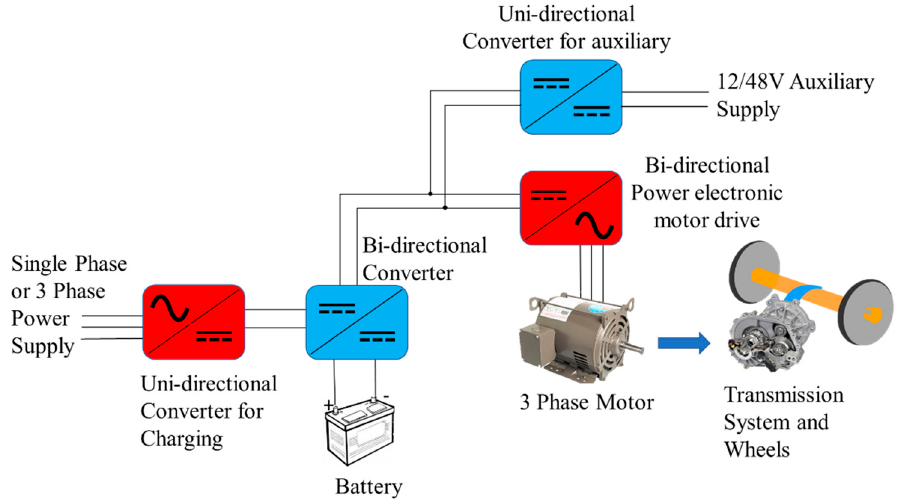
Figure 13. Power electronics in electric vehicles.